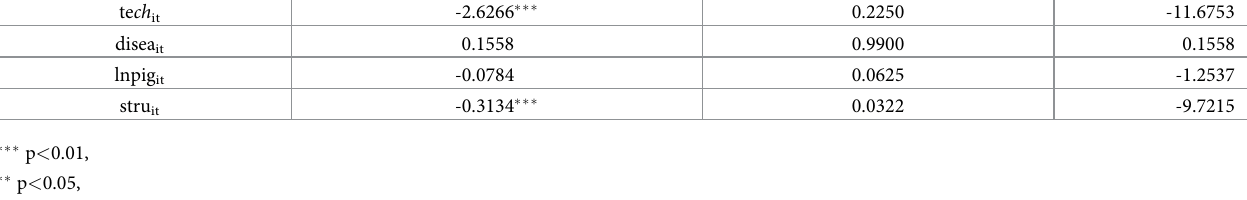
Analysis of influencing factors of cost inefficiency of sows. According to Frontier4.1 esti-